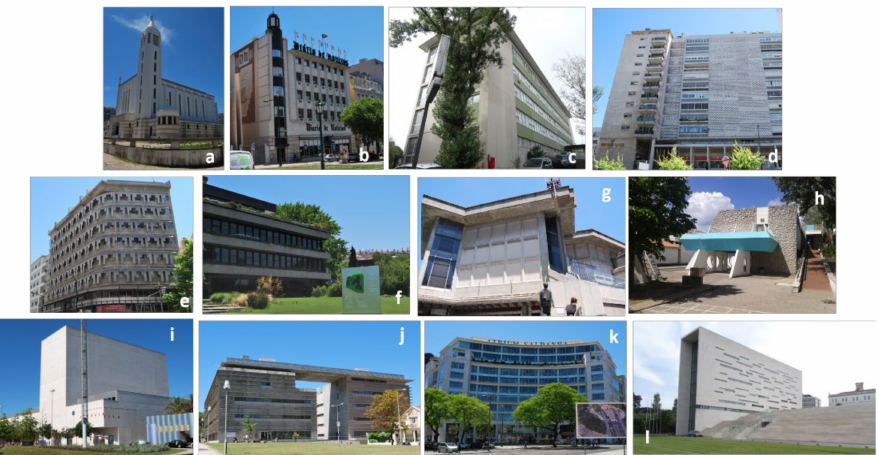
Figure 2. RCB case studies (acronym and award-winning year): ( a )—IRF (1938); ( b )—DN (1940); ( c )—LIP (1958); ( d )—EUA53 (1970); ( e )—FRAN (1971); ( f )—FCG (1975); ( g )—ISCJ (1975); ( h )—JRP (1987); ( i )—PCV (1998); ( j )—C8 (2000); ( k )—AS (2001); ( l )—UNL